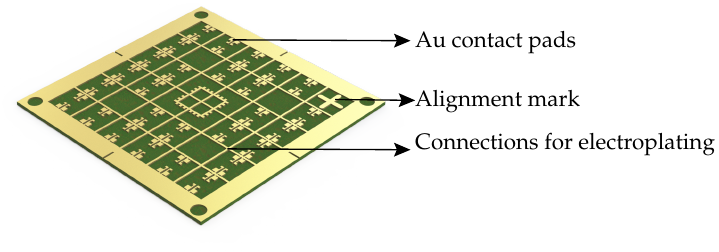
Figure 3. Schematic of the Au electroplated substrate.